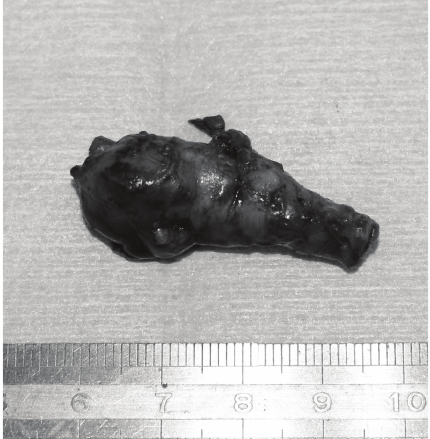
Figure 3: A resected specimen showing the popliteal artery with an adventitial